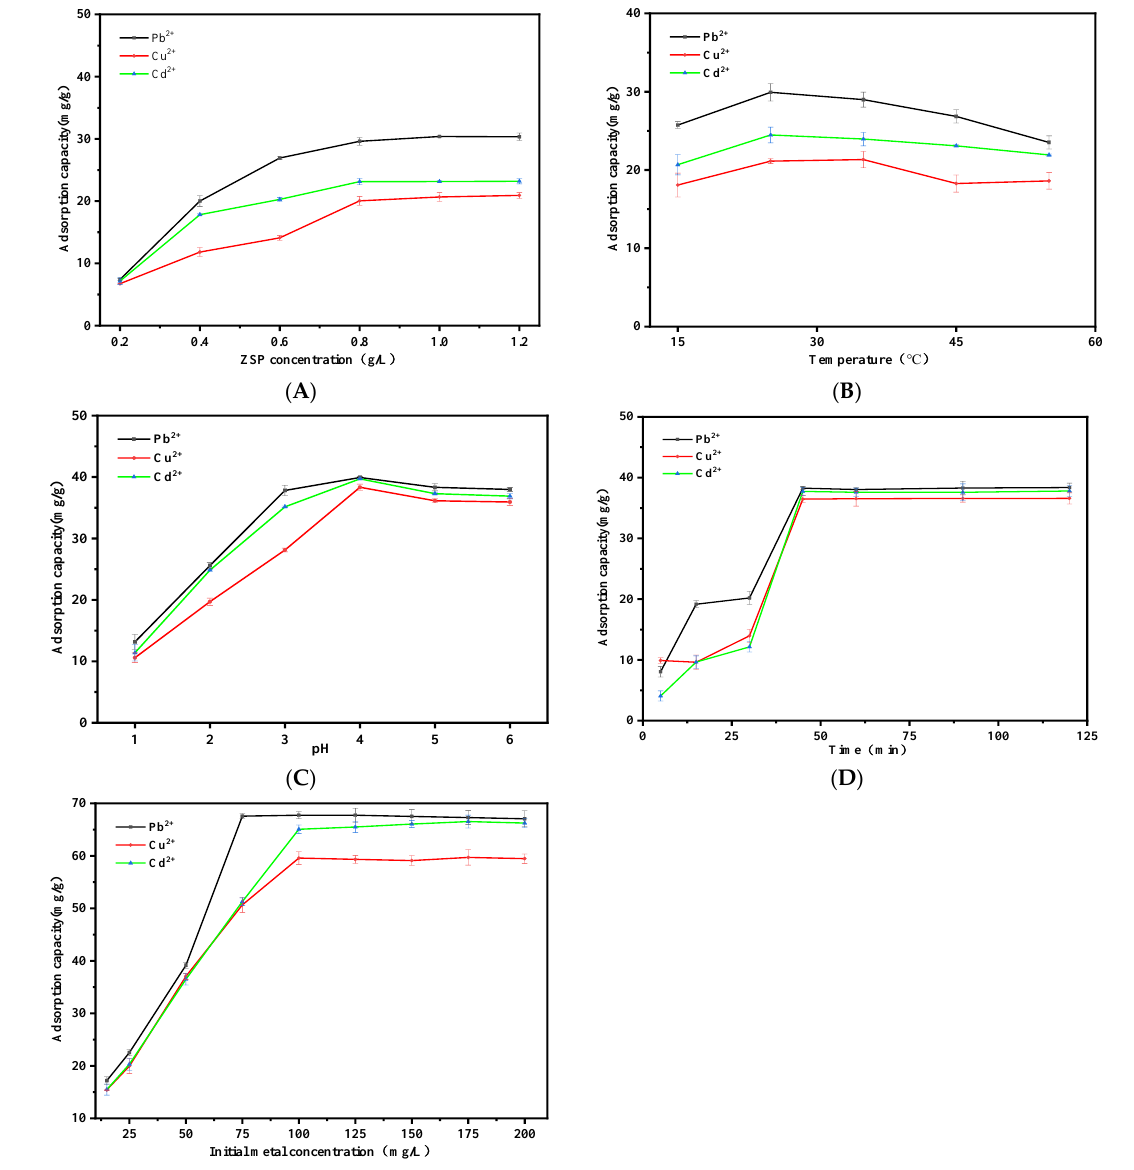
Figure 3. Influence of ZSP concentration ( A ), temperature ( B ), pH ( C ), time ( D ) and initial metal concentration ( E ) on adsorption of heavy metal ions. Table 2. Isotherm model parameters.